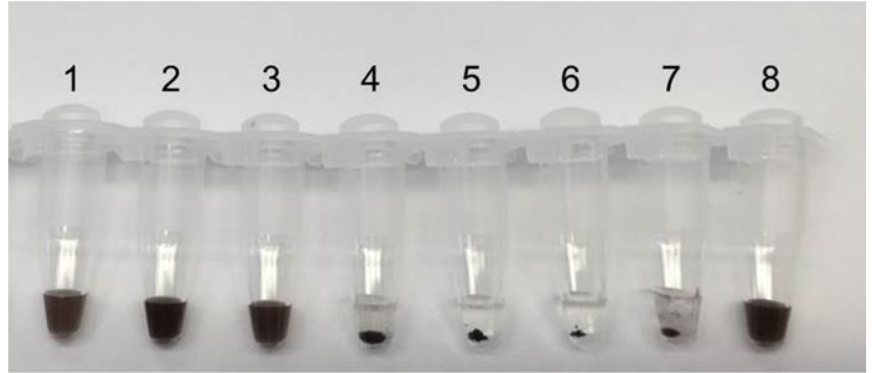
Figure 6. EHEC detection results. The concentration of EHEC is 1 × 10 3 CFU/mL. 1 – 8: ST, LT, ipaH, eae, Stx1, rfbE, uidA gene and negative control, respectively.